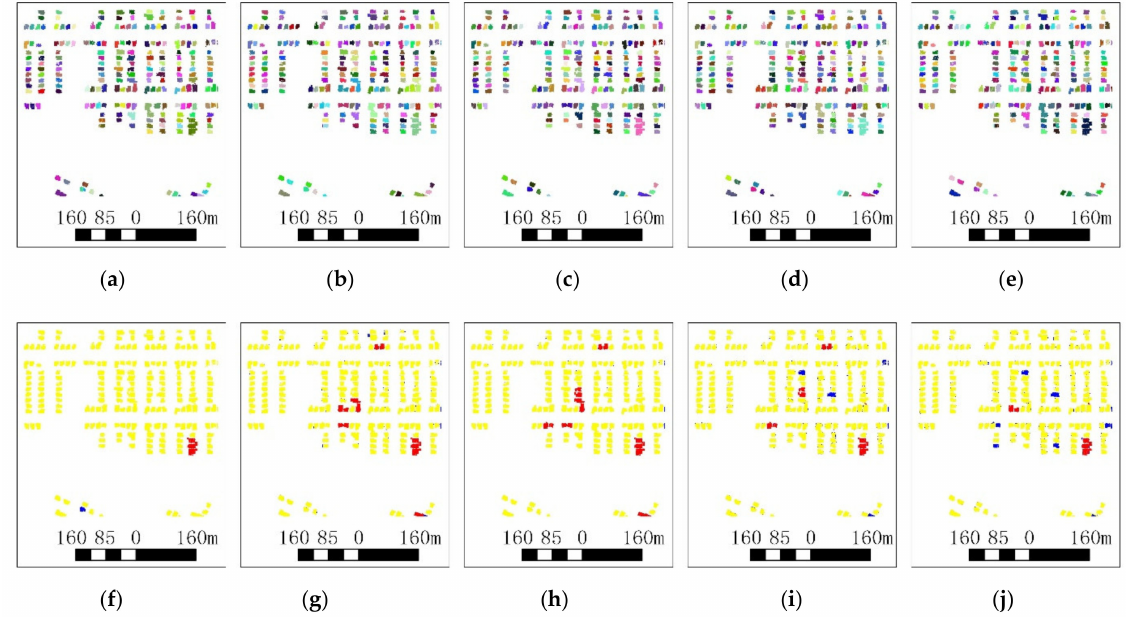
Figure 17. Building instance segmentation result comparison of dataset 5: ( a ) Result of the UBIS method; ( b ) result of the MV method; ( c ) result of the ES2D method; ( d ) result of the ES3D method; ( e ) the result of LCCP method; ( f ) the main differences between the result of the UBIS method and the ground truth; ( g ) the main differences between the result of the MV method and the ground truth; ( h ) the main differences between the result of the ES2D method and the ground truth; ( i ) the main differences between the result of the ES3D method and the ground truth; ( j ) the main differences between the result of the LCCP method and the ground